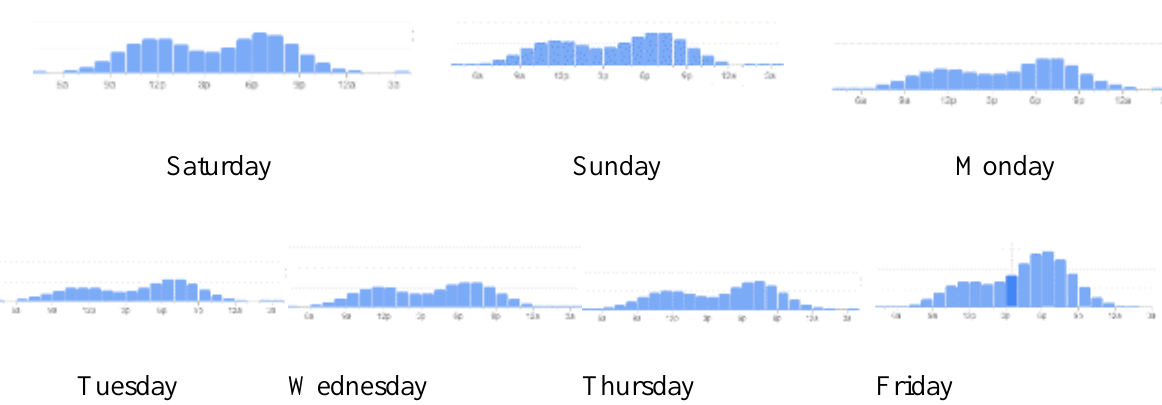
Figure 9. The featured an estimation for the use of Bab Al-Bahrain Avenue (Popular times in Bab Al Bahrain,